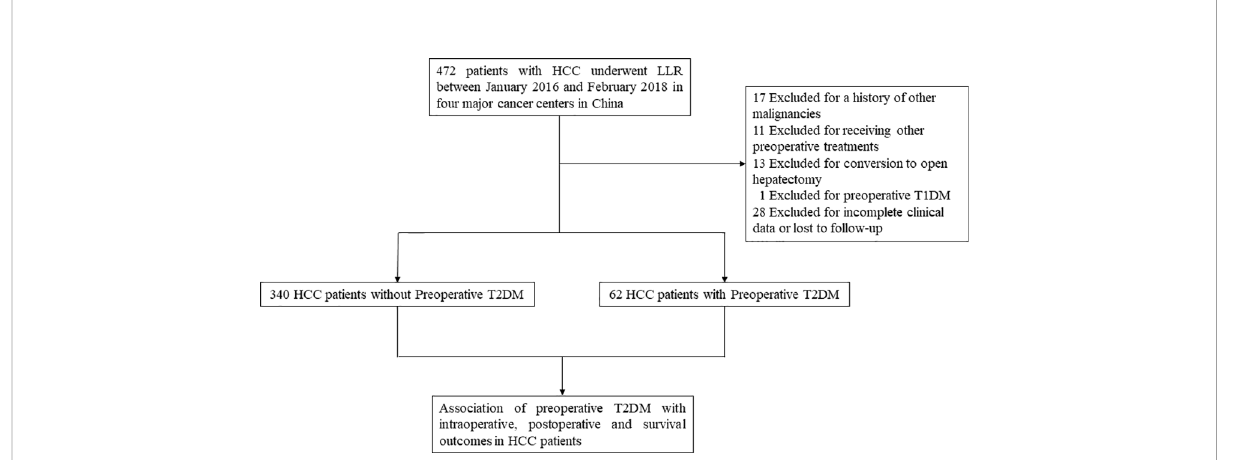
FIGURE 1 Study design frame and patient selection process. HCC, hepatocellular carcinoma; LLR, laparoscopic liver resection; T1DM, type 1 diabetes mellitus; T2DM, type 2 diabetes